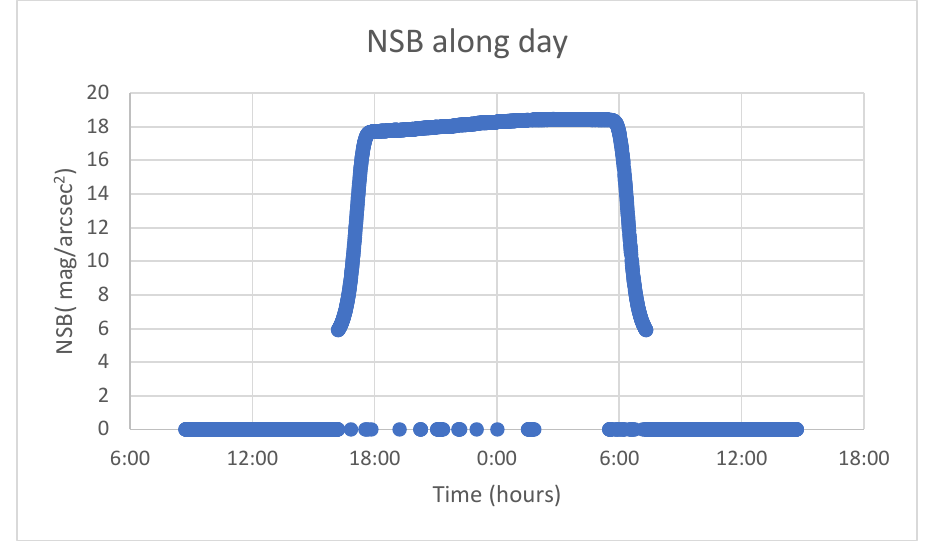
Figure 1. NSB curve of a random day in 2017 taken from the station at the National Astronomical Observatory of Japan. During diurnal hours, NSB values cannot be measured, while during nocturnal hours, NSB values rise, becoming stabilised and decreasing again.